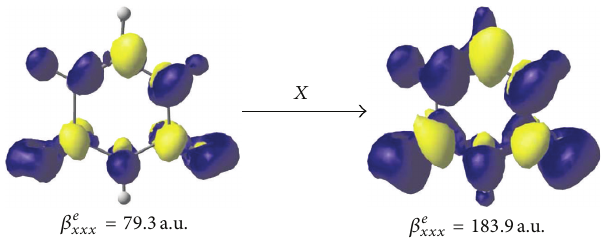
𝛽 xxxe = 79.3 a.u. 𝛽 xxxe = 183.9 a.u. Figure 2: Hyperpolarizability density distributions 𝜌 (2) 𝑥𝑥 (𝑟) of uracil in gas (left) and water solution (right). The yellow and blue surfaces (colour figure online) refer to positive and negative 𝜌 (2) 𝑥𝑥 (𝑟) densities, respectively, computed at the isosurface of 0.25 a.u. CAM- B3LYP/aug-cc-pVDZ